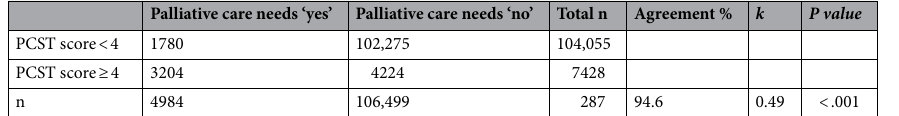
Table 3. Agreement between intuitive assessment of palliative care needs and PCST in predicting patients’ 6-month mortality. PCST, Palliative Care Screening Score.